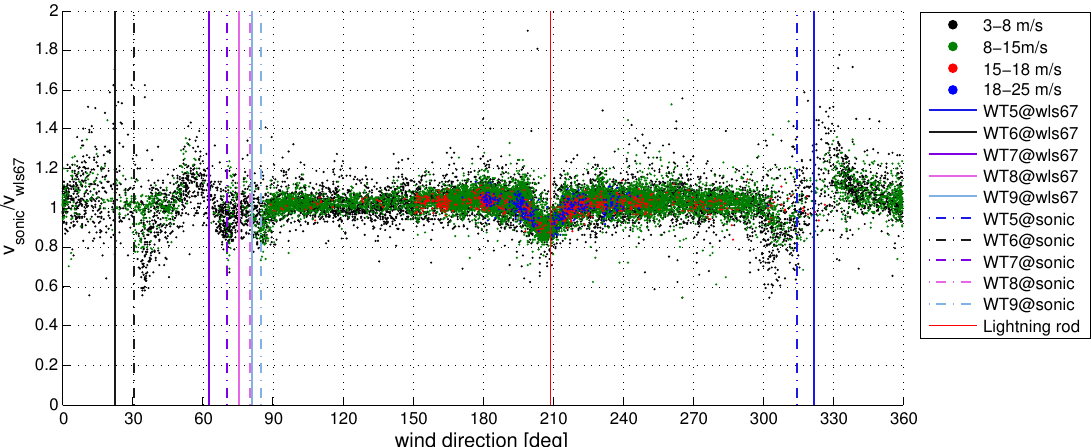
Figure 4. Wind speed ratios between the sonic anemometer measurements on M3 at 108m and the wls67 measurements at 108m on the basis of 10min averages. Different wind speed intervals are color-coded. The vertical red line indicates the effect of a lightning rod on the sonic anemometer measurements. The colored solid and dashed vertical lines mark the position of the expected wake effects of the five test turbines on the wls67 and sonic anemometer measurements,